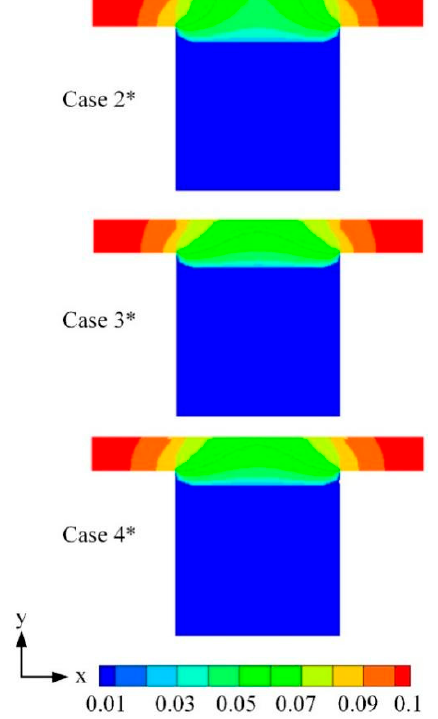
Figure 13. Distribution of effective diffusion coefficient (EDC) of oxygen in the GDL under different water contents in Case 2*, Case3* and Case 4*: ( a ) under the channel; ( b ) under the rib.